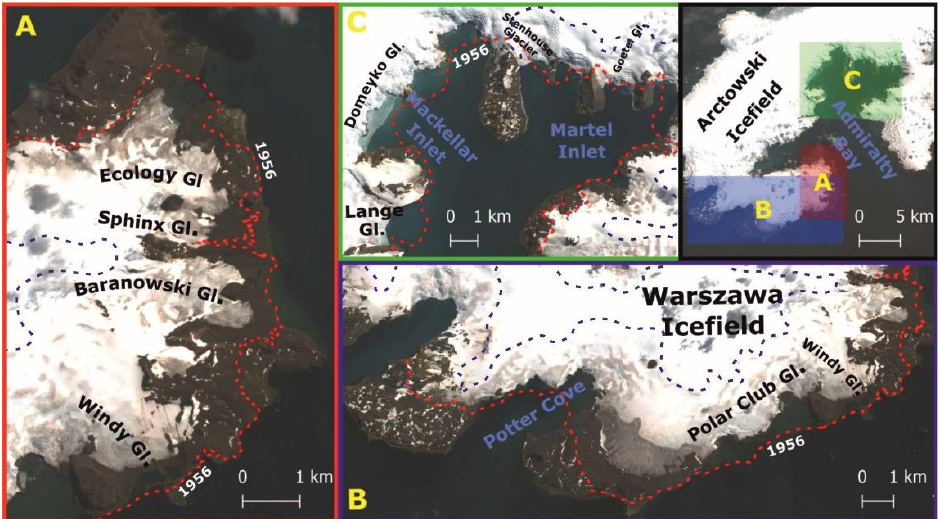
Figure 10. Retreating glaciers from 1956 to 2020. The background image is based on a Sentinel-2 satellite image (acquisition date: 19 January 2020). ( A ) West shore of Admiralty Bay; ( B ) Potter Peninsula region; ( C ) Area of Mackellar and Martel inlets. Blue line stands for TSL based on Simões and Bremer [56].